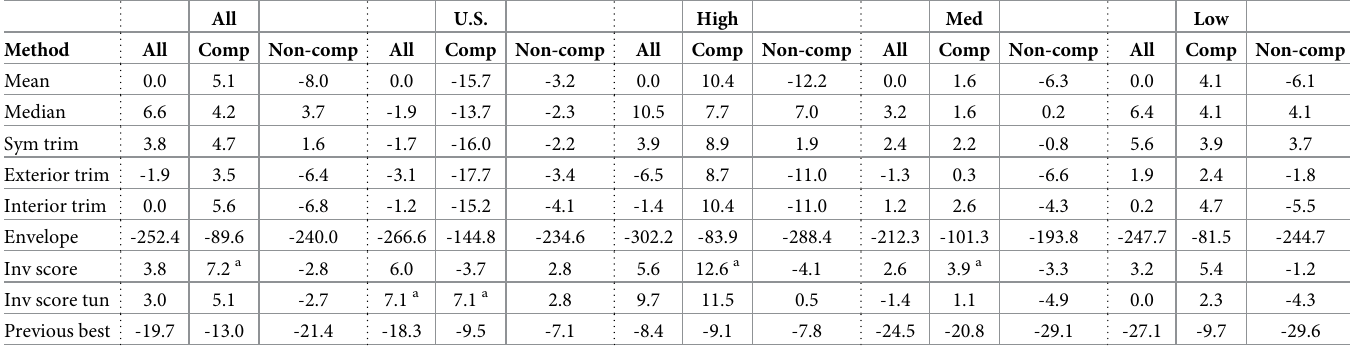
Table 5. For incident mortality, skill scores for MWIS for combining methods applied to forecasts of all models, compartmental models only, and non-compart- mental models only. All U.S. High